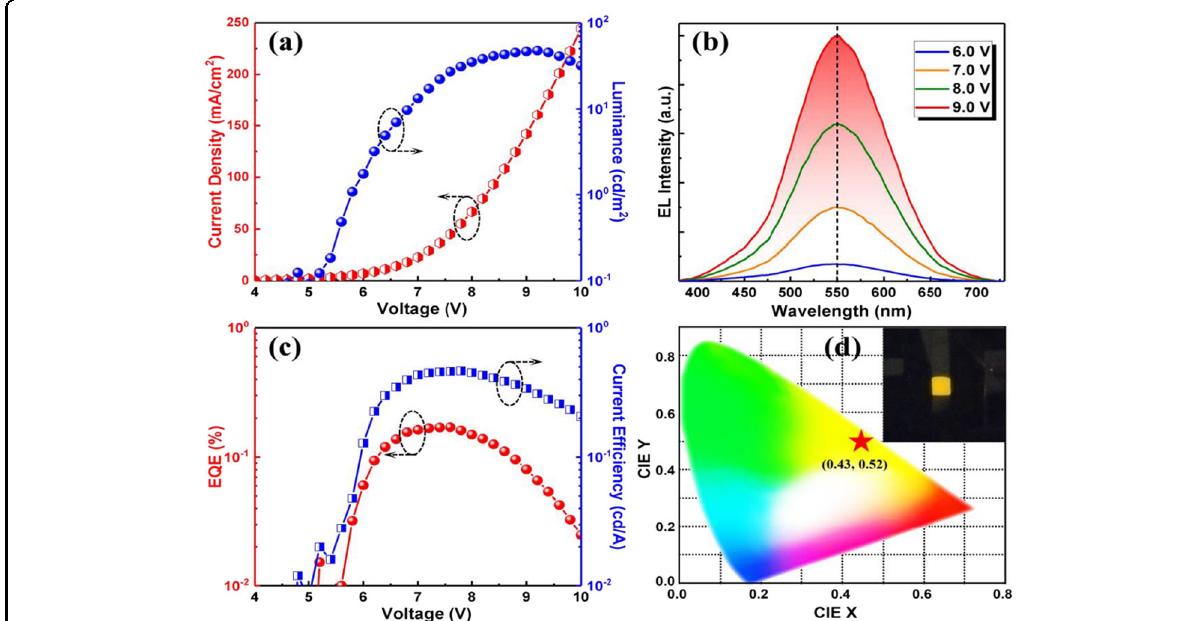
Fig. 12 Yellow LED based on 1D CsCu 2 I 3 . a Current density (red) and luminance (blue) versus voltage for the LEDs. b EL spectra for various voltages. c EQEs and plots of current ef fi ciency versus voltage for the LEDs. d CIE color coordinates of the LED. Reproduced with permission